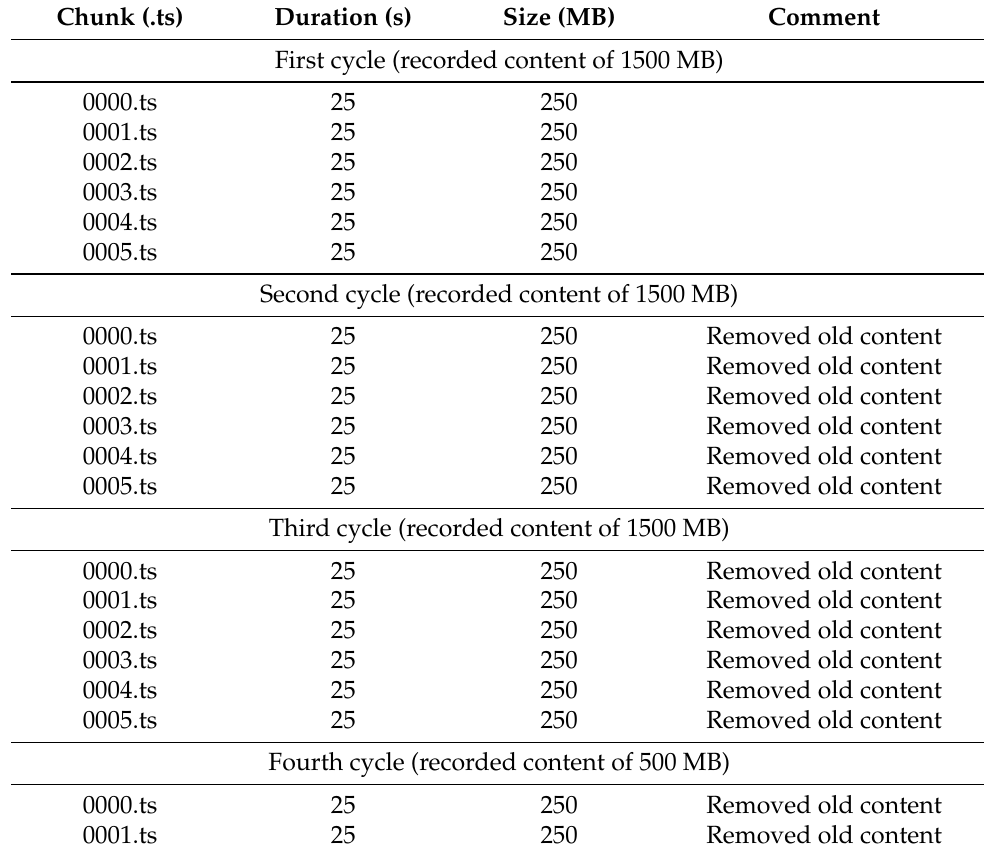
Table 3. Results of the circular buffer solution. Chunk (.ts) Duration (s) Size (MB)